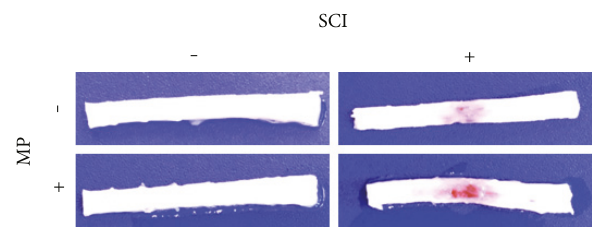
Figure 1: Tissue damage and subarachnoid hemorrhage following SCI. Representative photographs ( n = 5 per group) of spinal cord segments T5-6 to L1-2 showing the lesion caused by SCI 24h after contusion. Injured spinal tissues present swelling and subarachnoid hemorrhage in the animals treated with MP and control